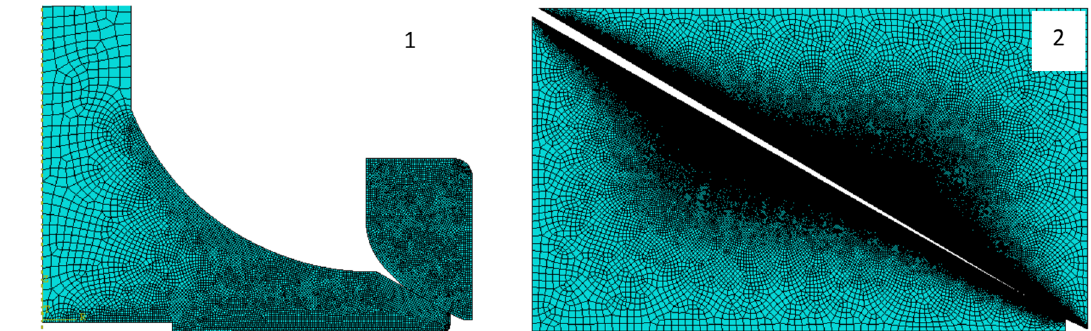
Fig. 20. Mesh of the fi nite element model in its axisymmetric con fi guration, (1) global axisymmetric model with large elements, (2) Sub-model with re fi ned mesh.